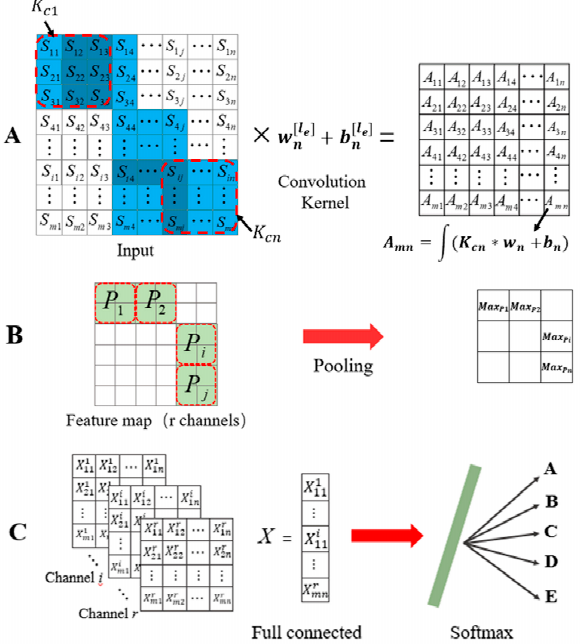
Figure 3. A schematic depiction of CNN feedforward, ( A ) convolution layer, ( B ) pooling layer, ( C ) fully connected and output layers.